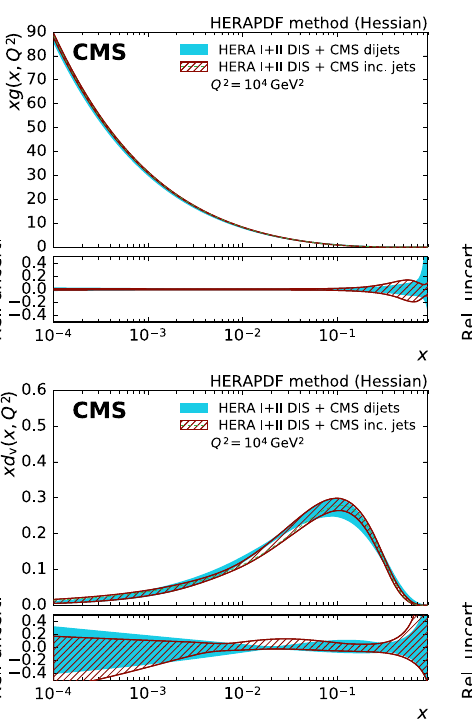
The PDFs are compared in Fig. 11 to those obtained with